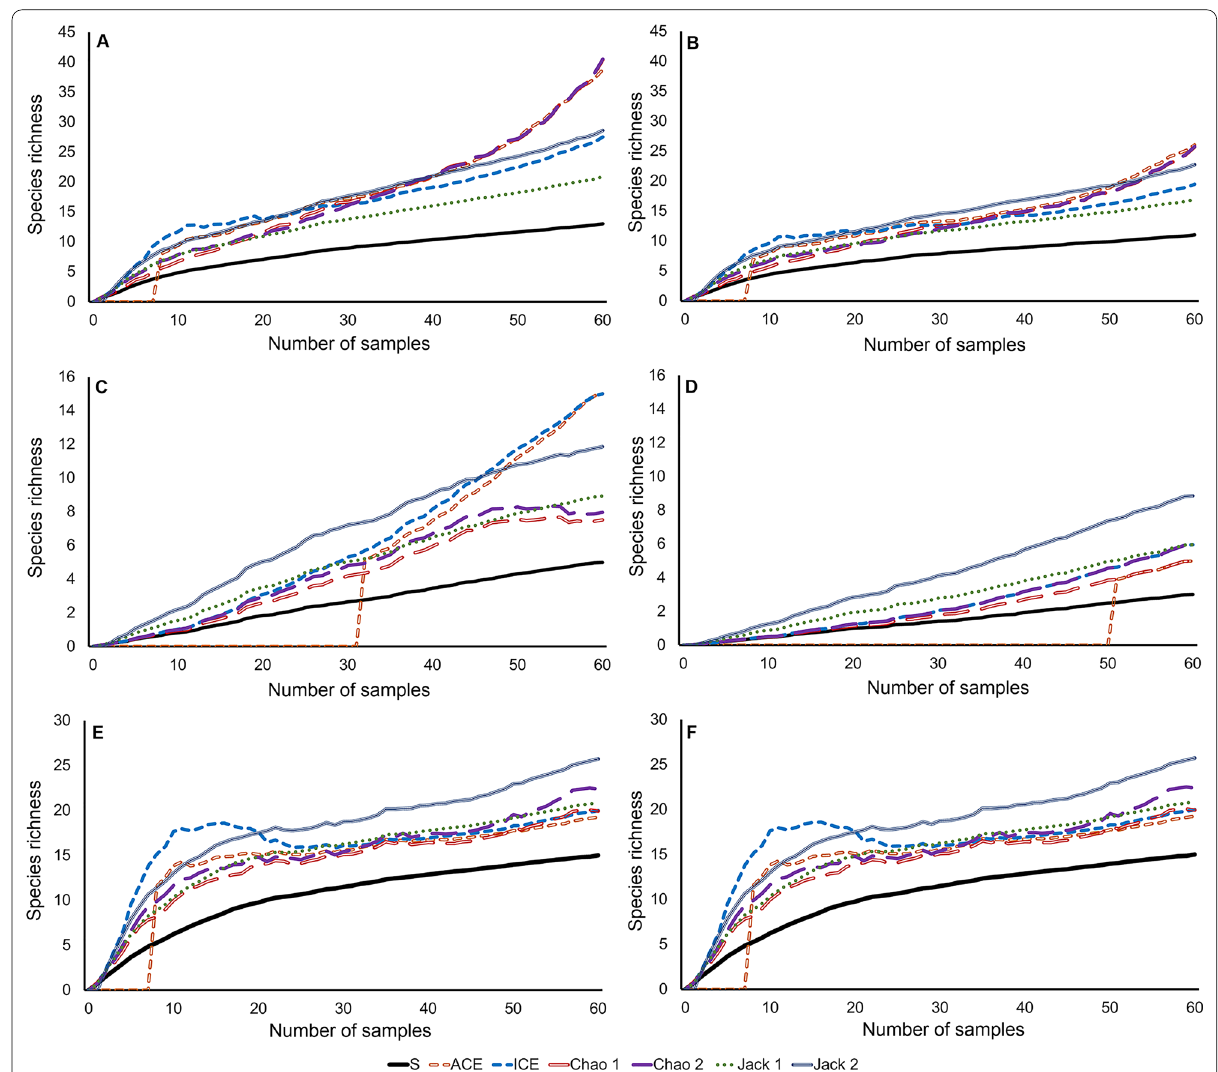
Fig. 5 Species richness estimation curves for semi-natural site 1, Chaco, Argentina, with adult data. A , B : foliage, C , D : leaf litter, E , F : grassland; A – C – E : analyses with HTS; B – D – F : analyses without